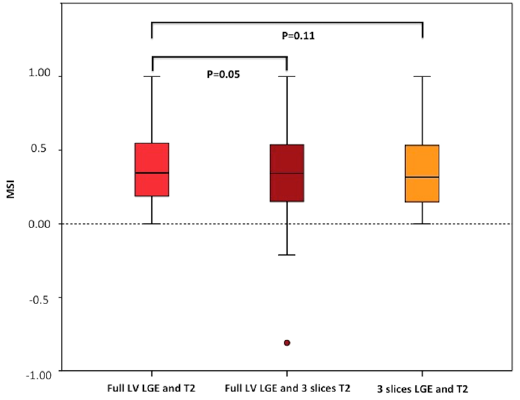
Figure 3. Performance of the 3 approaches for the T2-based MSI. Box and whisker plots of the MSI by T2 using full LV coverage for both the MI size and AAR; 3-slice approach for AAR and full LV coverage for the MI size; and 3-slice approach for both the MI size and AAR. The MSI using 3-slice approach for AAR and full LV coverage for the MI size resulted in negative MSI in 7 patients.